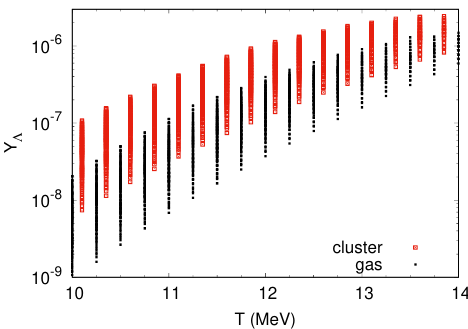
Figure 17. Λ fraction as a function of temperature in the cluster and gas phases with the NL3 ωρ parametrization [46]. Figure taken from [109].